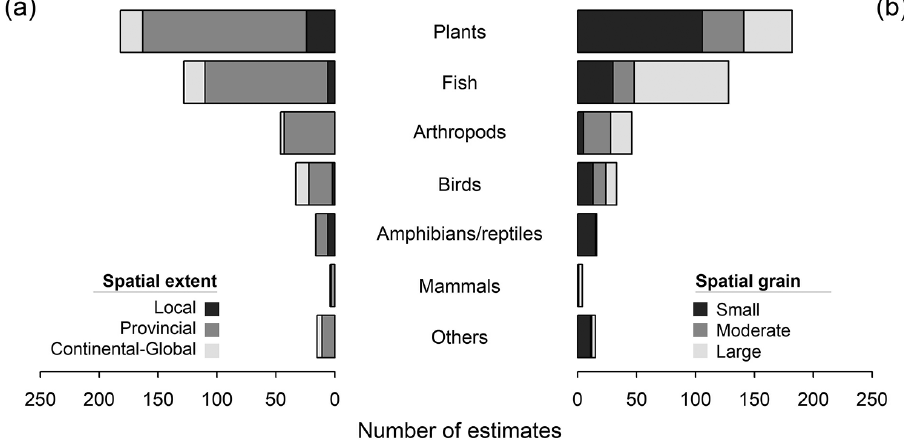
Figure 3. Spatial (a) extent (local < 100 km 2 ; provincial; continental-global) and (b) grain (small < 10 km 2 ; 10 km 2 ≤ moderate ≤ 1000 km 2 ; large > 1000 km 2 ) of estimates reported in biotic homogenisation